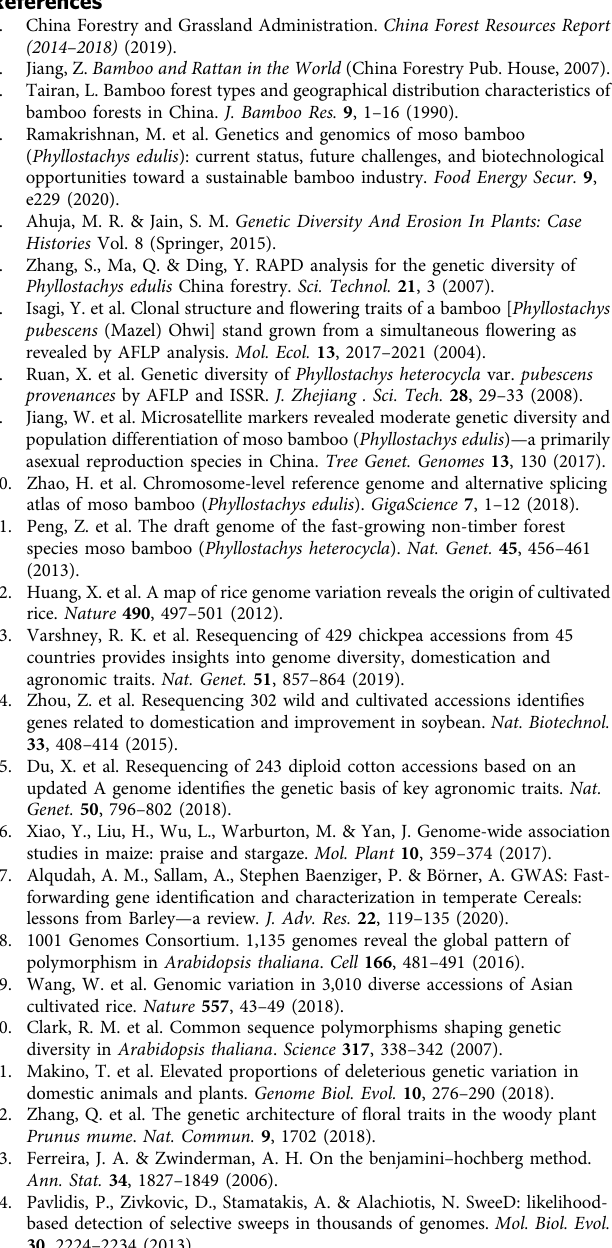
National GeneBank (CNGB) under accession number CNP0001535. The datasets of twelve (listed in Supplementary Table 8). For SMC ++ , we used SNPable (http:// environmental factors were adapted from a previous study 72 . ETOPO2v2c Global Gridded lh3lh3.users.sourceforge.net/snpable.shtml, accessed Nov. 2019), MSMC mapp- 2-min elevation and bathymetric data are available at US National Centers for Environmental ability, and BEDTools 65 (version 2.28.0) to prepare the input fi le (-mask, the loci to Information library (https://doi.org/10.7289/V5J1012Q; https://www.ncei.noaa.gov/access/ be excluded) for SMC ++ . For both methods, we used an estimated mutation rate metadata/landing-page/bin/iso?id = gov.noaa.ngdc.mgg.dem:301). Source data are provided of 8.51 ×10 − 8 and the generation time of 67 years 66 . The nucleotide mutation rate with this ( μ ) was estimated following Eq. 1 μ ¼ D ´ g = 2 T ð 1 Þ where D is the observed frequency of pairwise differences between two species, T is the estimated divergence time, and g is the estimated generation time for the two species 67 . Olyra latifolia was selected as the comparison species. In this study, we fi rst aligned the two genomes using NUCmer 68 (version 4.0.0), and the median of the sequence divergence was 0.1069 (Supplementary Fig. 21). The generation time ( g ) was set to 67 years 66 , and the estimated divergence time was 42.1 million years ago 69 , so that a mutation rate of 8.51×10 − 8 mutations per site per generation was estimated. Measurement of agricultural traits . We investigated nine agricultural traits of the sequenced individuals, including three growth-related traits (clear culm height, node number, and ground diameter) and six property-related traits (density, compressive strength, bending strength 12°, elastic modulus, maximum load, and